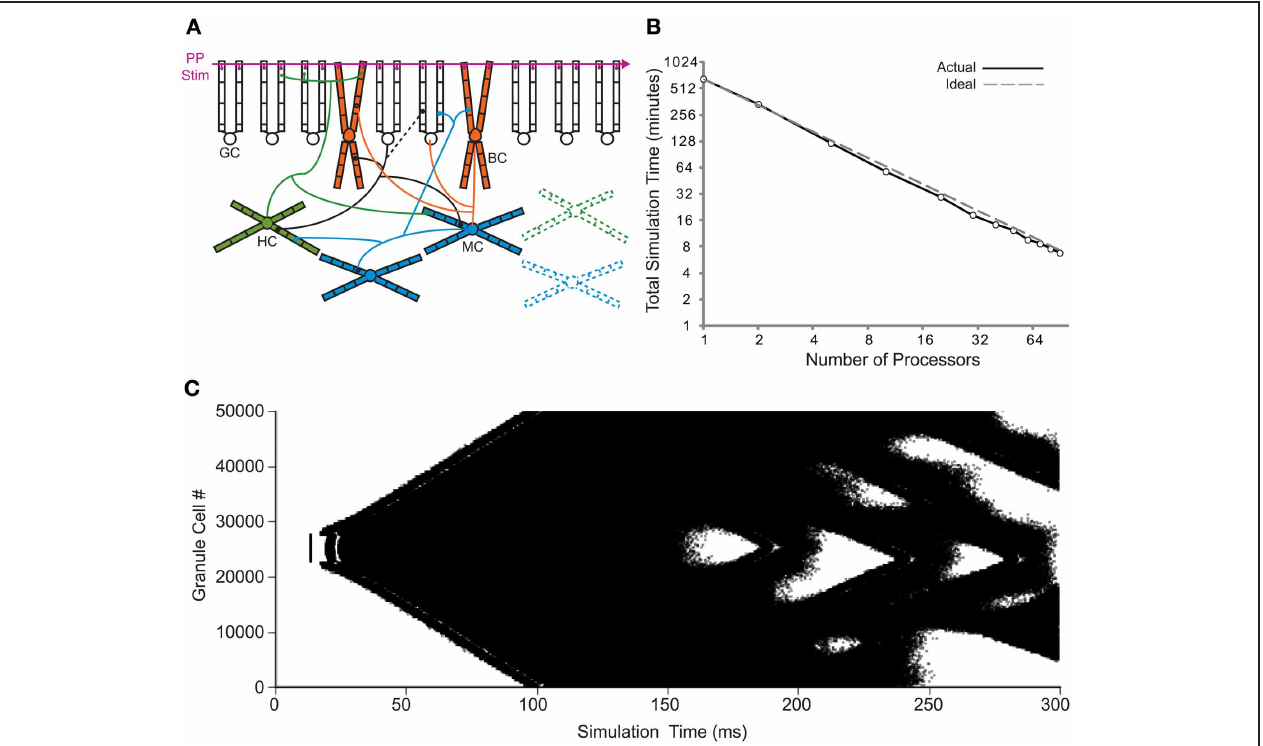
cells synapse onto other granule cells (changes are represented by dashed lines). GC, granule cell; BC, basket cell; HC, HIPP cell; MC, mossy cell; and PP Stim, perforant path stimulation. (B) Runtime of 80% injured network simulations versus the number of processors for actual and ideal scaling. (C) Granule cell activity for the parallel 1:20 scale model. Each dot represents a single granule cell spike.